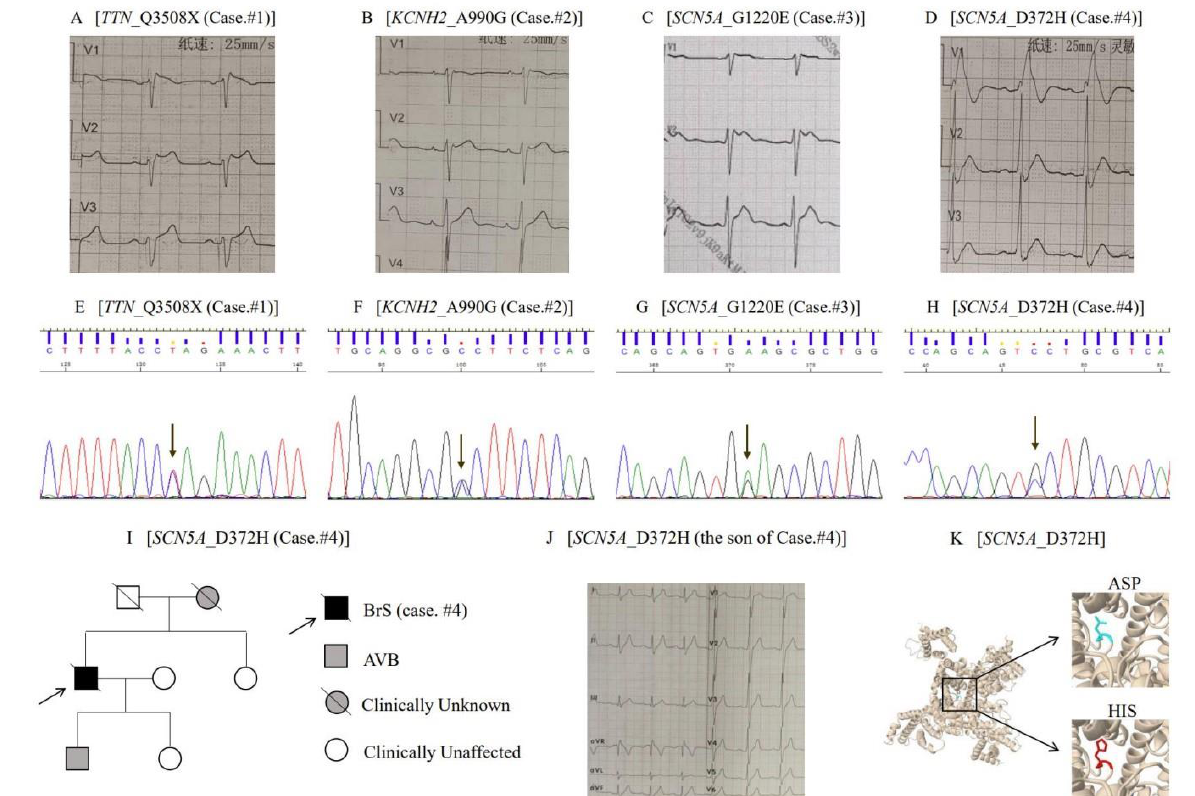
Figure 3. Representative cases of BrS with novel likely pathogenic or pathogenic mutations. ( A – D ) Each panel shows an electrocardiogram of BrS cases carrying novel mutations. ( E – H ) All 4 novel mutations of BrS identified in the study were validated by Sanger sequencing. ( I ) Pedigree of a rep- resentative family (Case 4) with SCN5A likely pathogenic mutation. ( J ) An electrocardiogram of the son of case 4. ( K ) The schematic structure and details of D372H in SCN5A was predicted with Mis- sense3D. BrS = Brugada syndrome; and AVB = atrioventricular block.